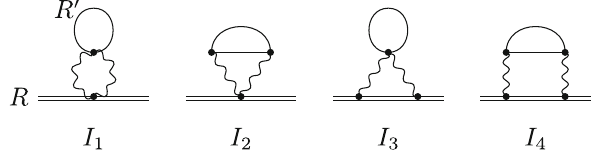
Fig. 1 Two-loop diagrams in which the representation R (cid:2) (solid line) can contribute to the self energy, and therefore the critical mass, of the fermion in the representation R (double solid line). These diagrams, apart from group theoretical invariants, depend on factors that have been computed in Ref.